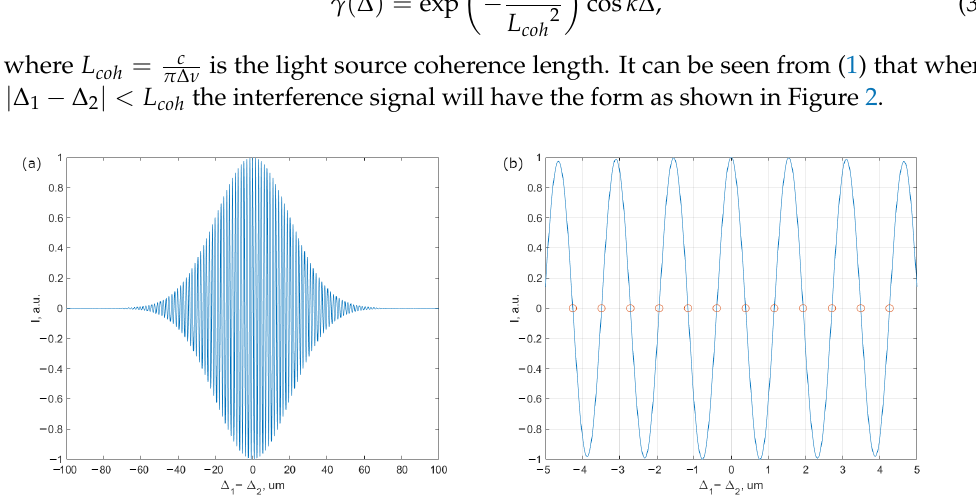
Figure 2. Low coherence signal: ( a ) full signal near | ∆ 1 − ∆ 2 | ≈ L coh . ( b ) Expanded signal with marked points of maximum sensitivity (red